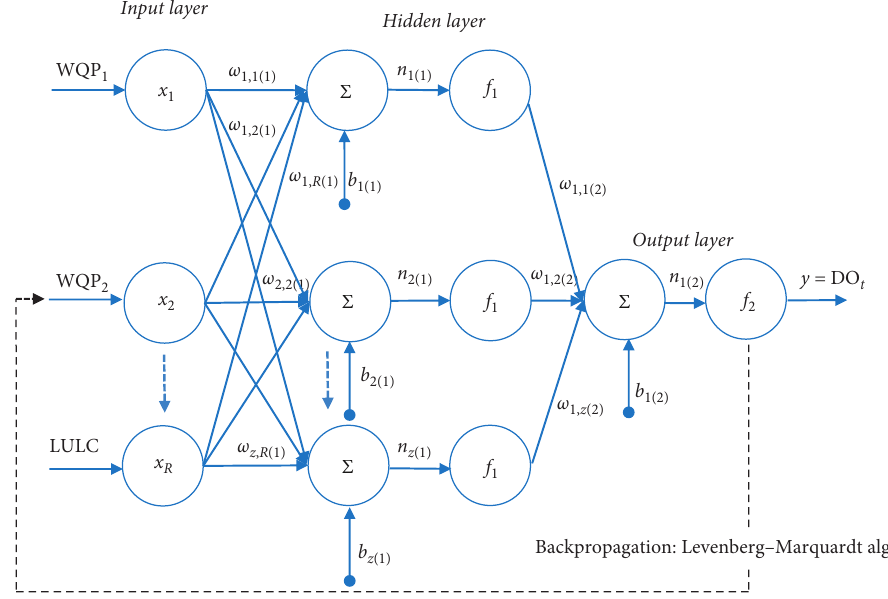
Figure 4: Architecture of the adopted feedforward backpropagation neural network